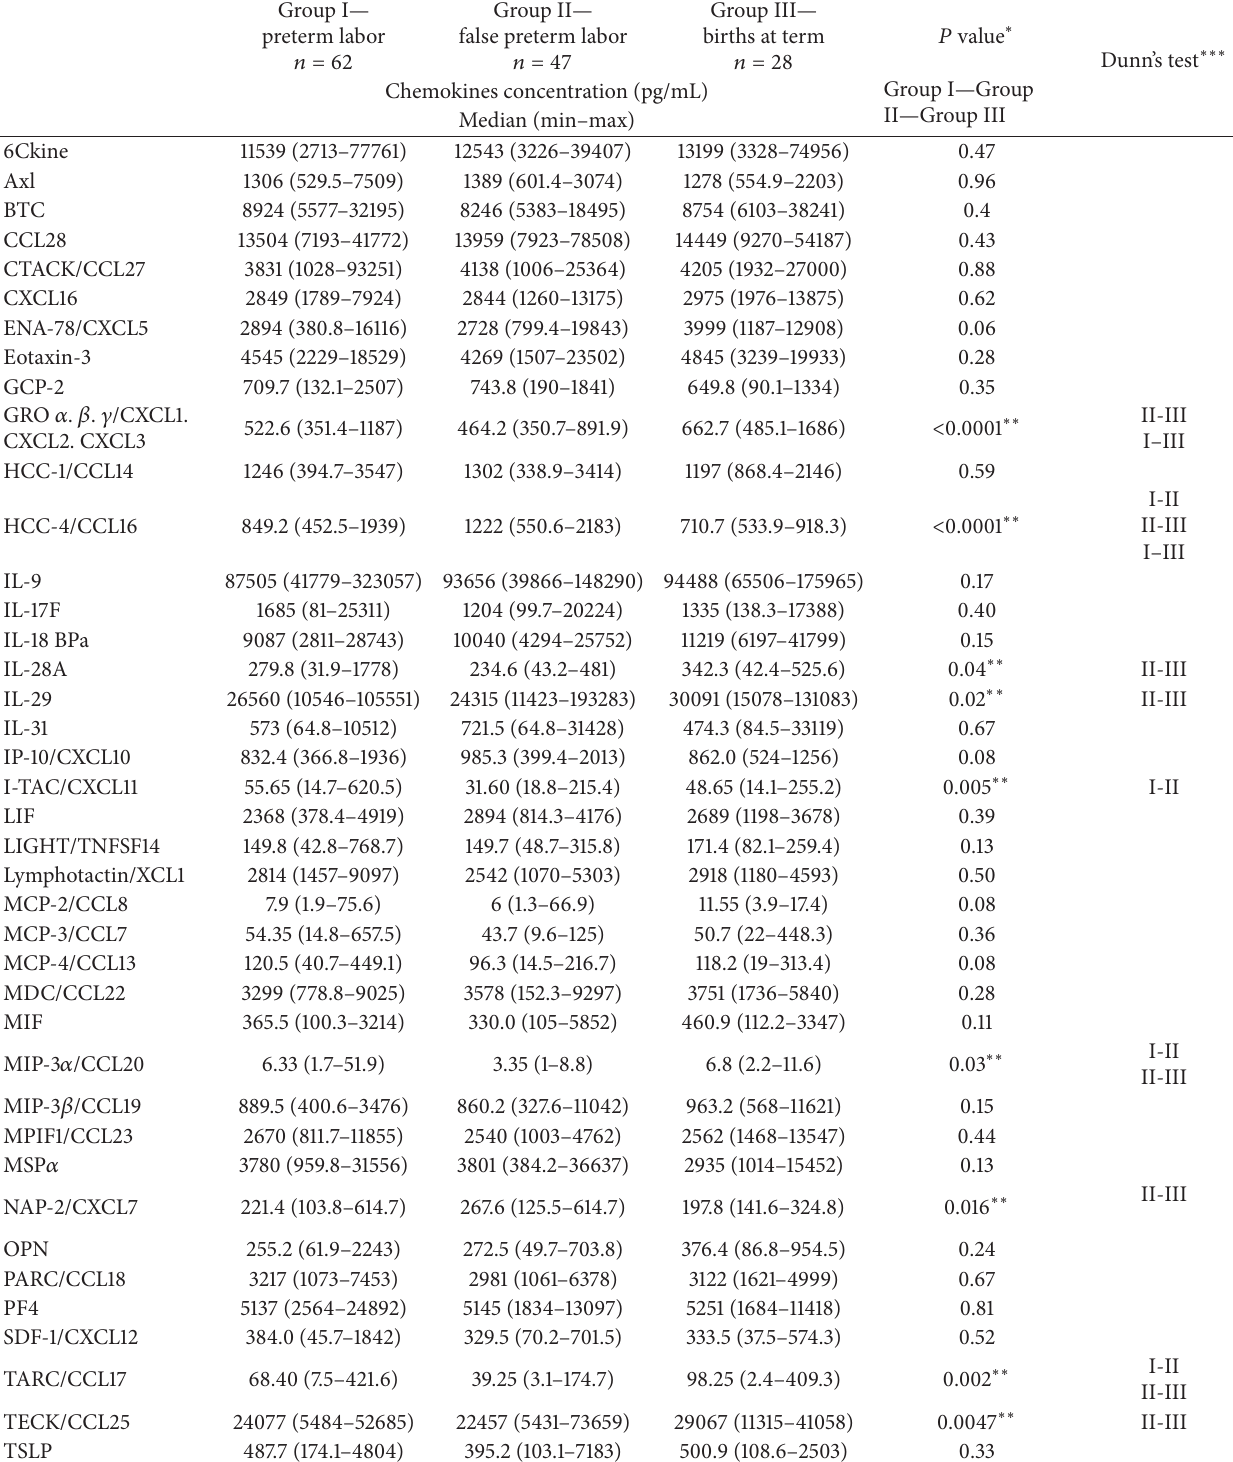
Table 2: Concentration of chemokines in maternal